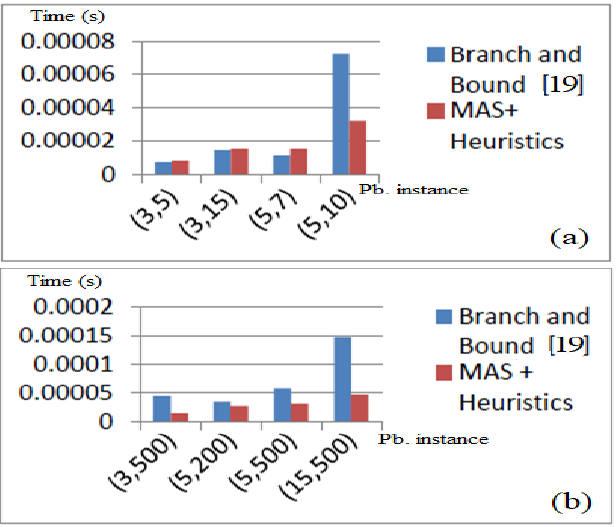
Figure 12. Obtained results; ( a ) for small size instances, ( b ) for big size instances.